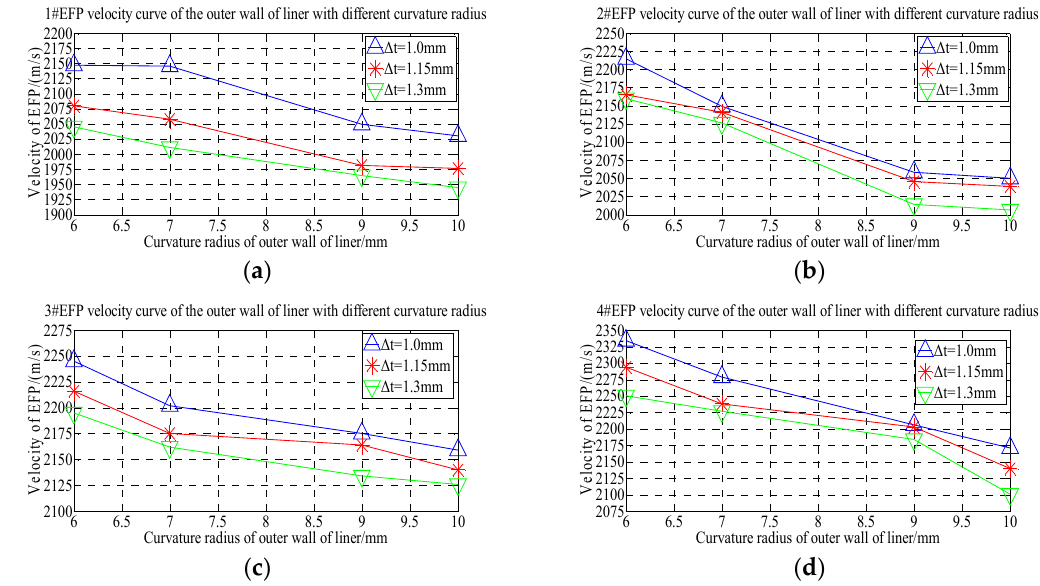
Figure 10. 1#EFP-4#EFP velocity curve of the outer wall of the liner with different curvature radius: ( a ) 1#EFP velocity curve; ( b ) 2#EFP velocity curve; ( c ) 3#EFP velocity curve; ( d ) 4#EFP velocity curve.